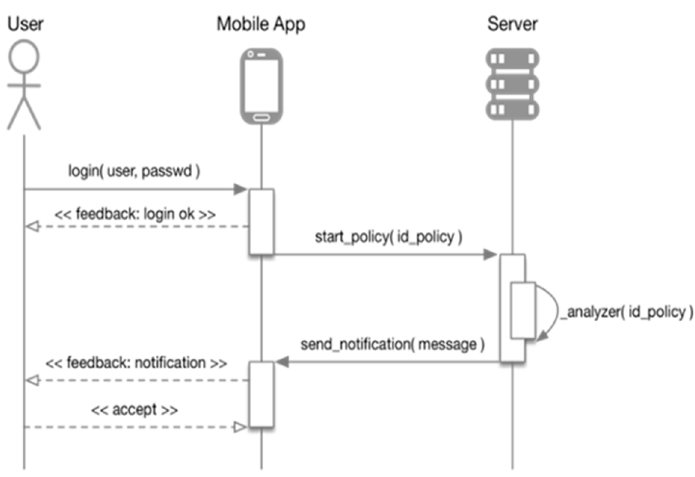
Figure 6. Sequence diagram of the action policy execution and interactions involved.